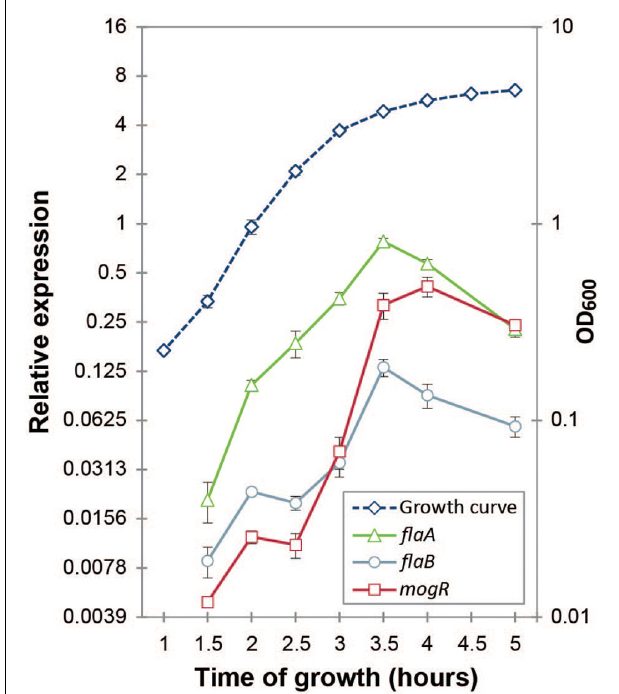
FIGURE 3 | Gene expression analysis of mogR and flagellin genes flaA and flaB by RT-qPCR. The expression of each gene at each time-point was normalized to the expression of the reference genes gatB , rpsU and udp . Cultures were grown at 30 ◦ C in bactopeptone culture medium, with the growth curve plotted on the right-hand vertical axis. Averages and standard errors of the means from three independent experiments are shown.